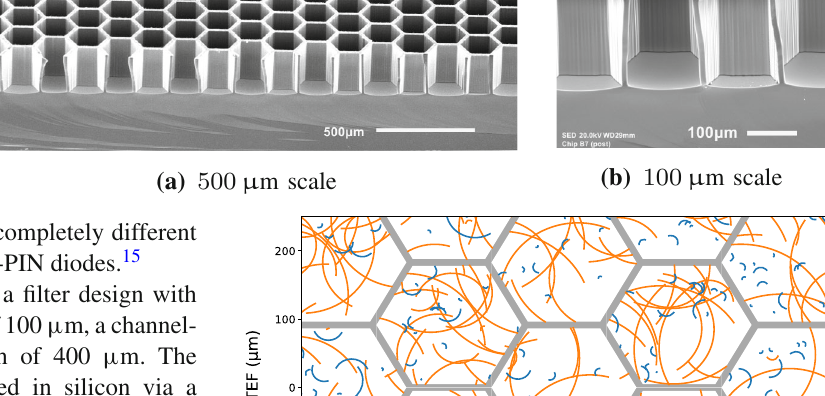
Fig. 6 Images of a silicon microstructure fabricated in the Münster Nanofabrication facility 13 via ICP-RIE, taken with a JEOL 14 JSM-IT100 scanning electron microscope. The hexagon side length is 100 µ m, wall thickness 10 µ m